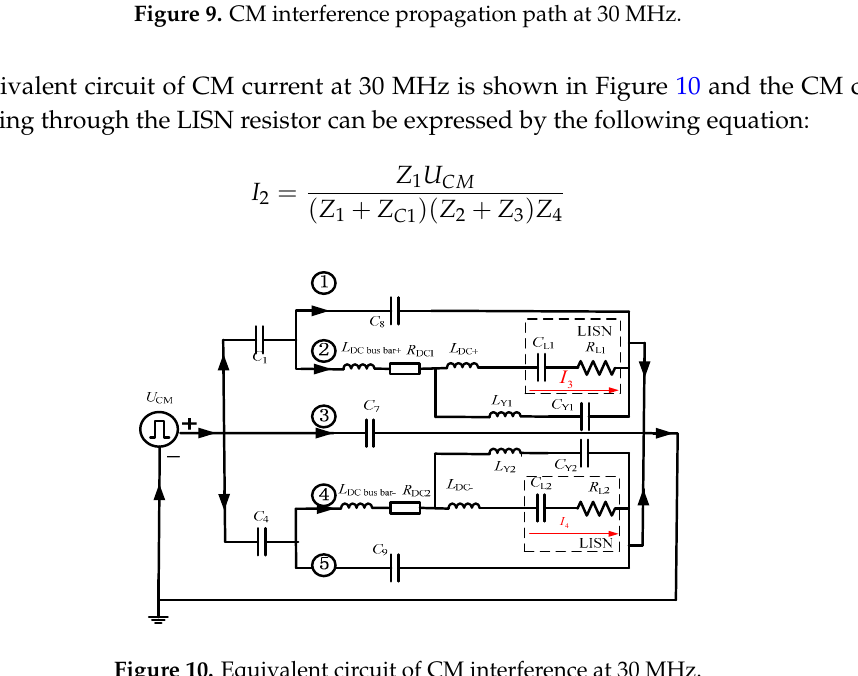
Figure 10. Equivalent circuit of CM interference at 30 MHz.